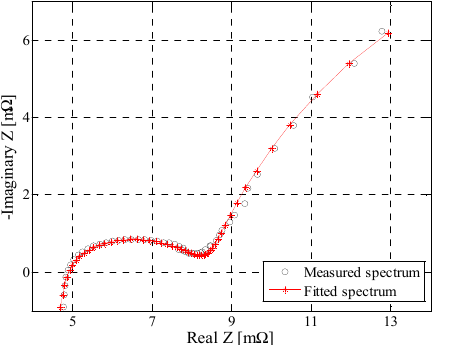
Figure 14. Measured and fitted impedance spectrum using the EEC presented in Figure 13.